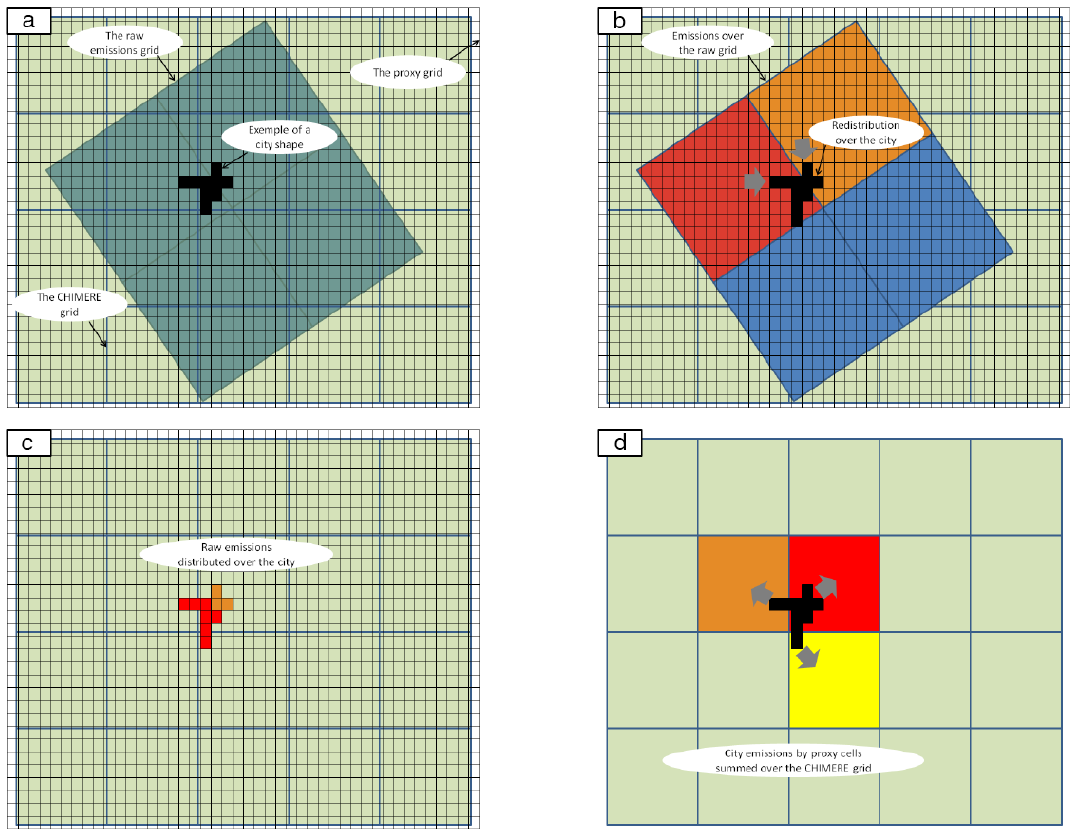
Figure 5. Downscaling strategy for the anthropogenic